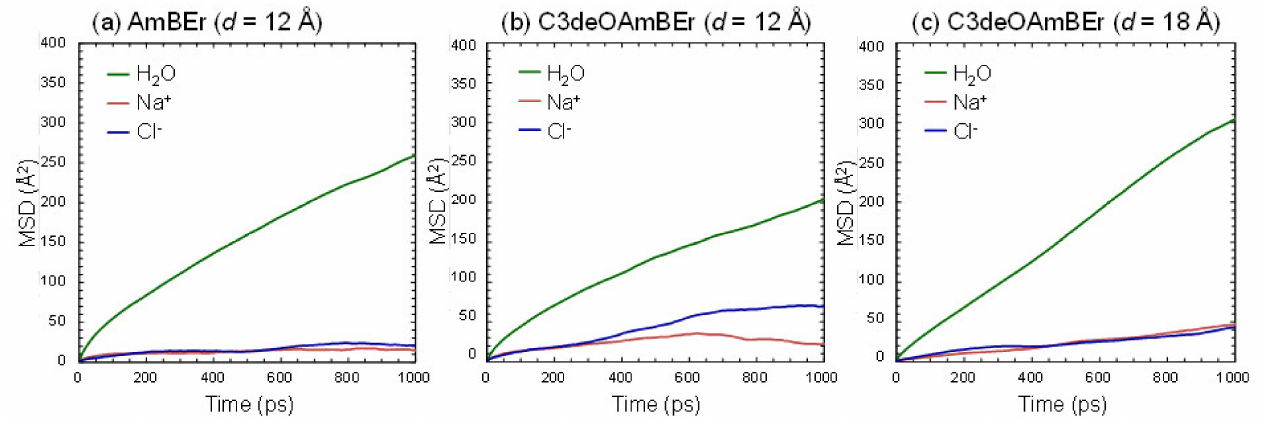
Figure 6. Mean square displacement (MSD) of water molecules and ions within ( a ) the AmBEr channel ( d = 12 Å), ( b ) the C3deOAmBEr channel ( d = 12 Å), and ( c ) the C3deOAmBEr channel ( d = 18